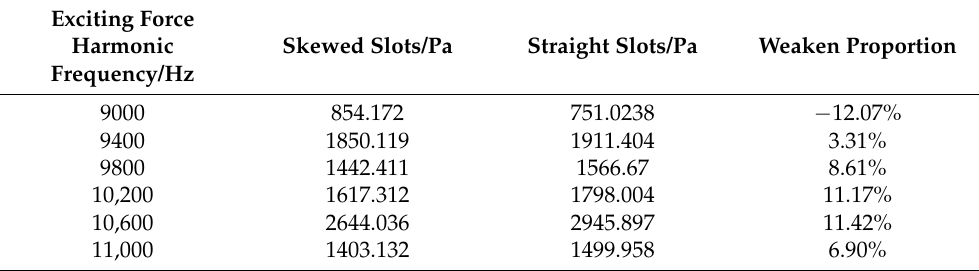
Table 5. Amplitude of excitation force obtained by one-dimensional Fourier